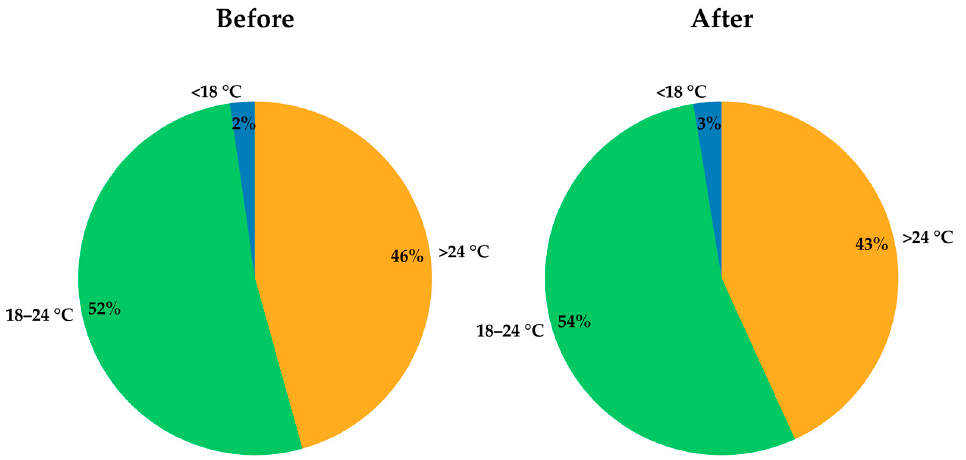
Figure 12. Room temperature distribution of the Greek pilot site while occupants are present in the room before and after renovation.